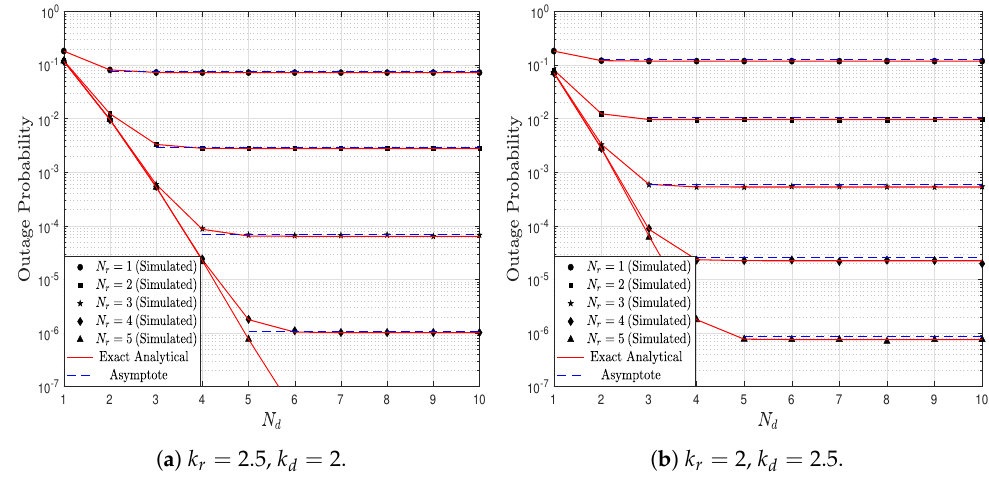
Figure 6. OP as a function of N d , parameterized by N r , k r and k d , considering E s / N 0 = 10 dB, and λ r = λ d =